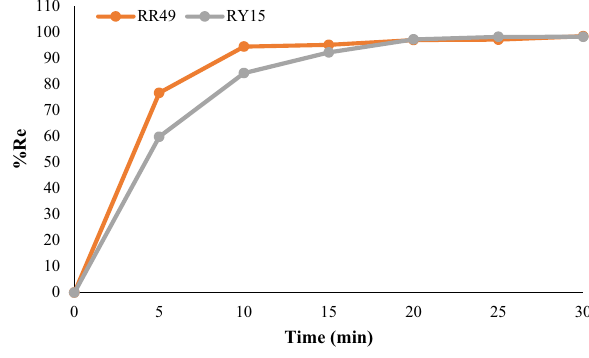
Fig. 8 Time effect on % Re at different quantities of NaCl (g/L) under optimum conditions, a RR49, b RY15 Fig. 9 Effect of time on % Re at 0.5 g NaCl for RR49 and